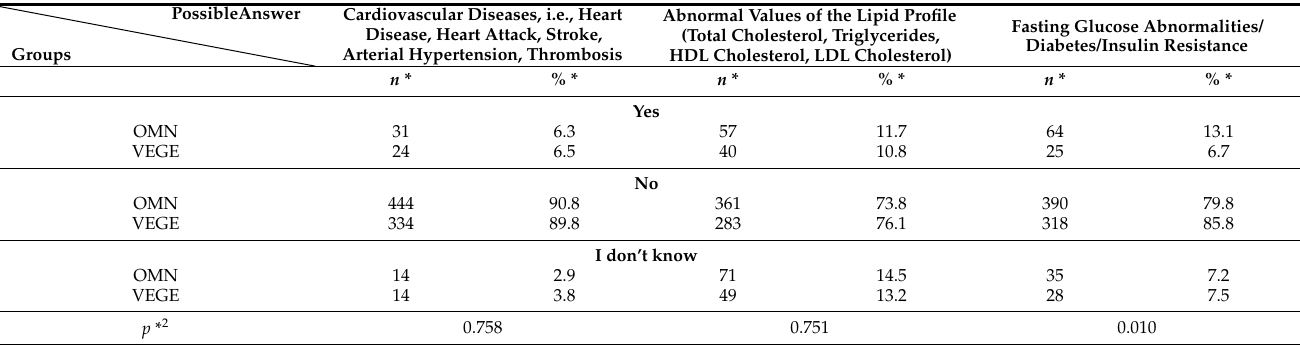
Table 3. Medical conditions of the respondents.